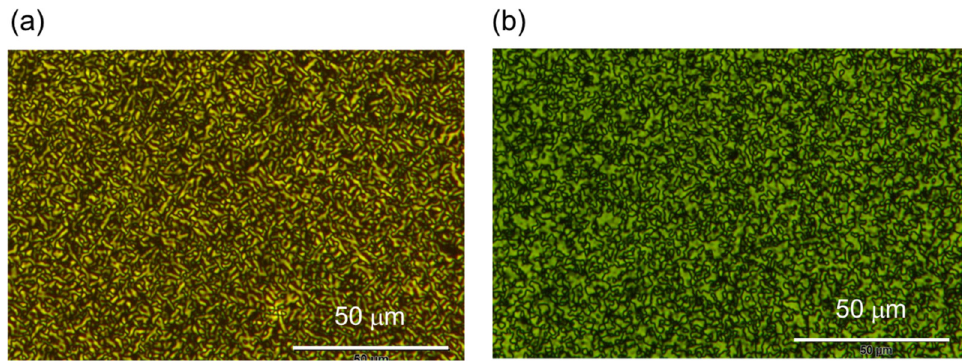
Figure 3. POM images of PAz of 100-nm thickness covered with PBMA films 100 nm ( a ) and 400 nm ( b ) thick.